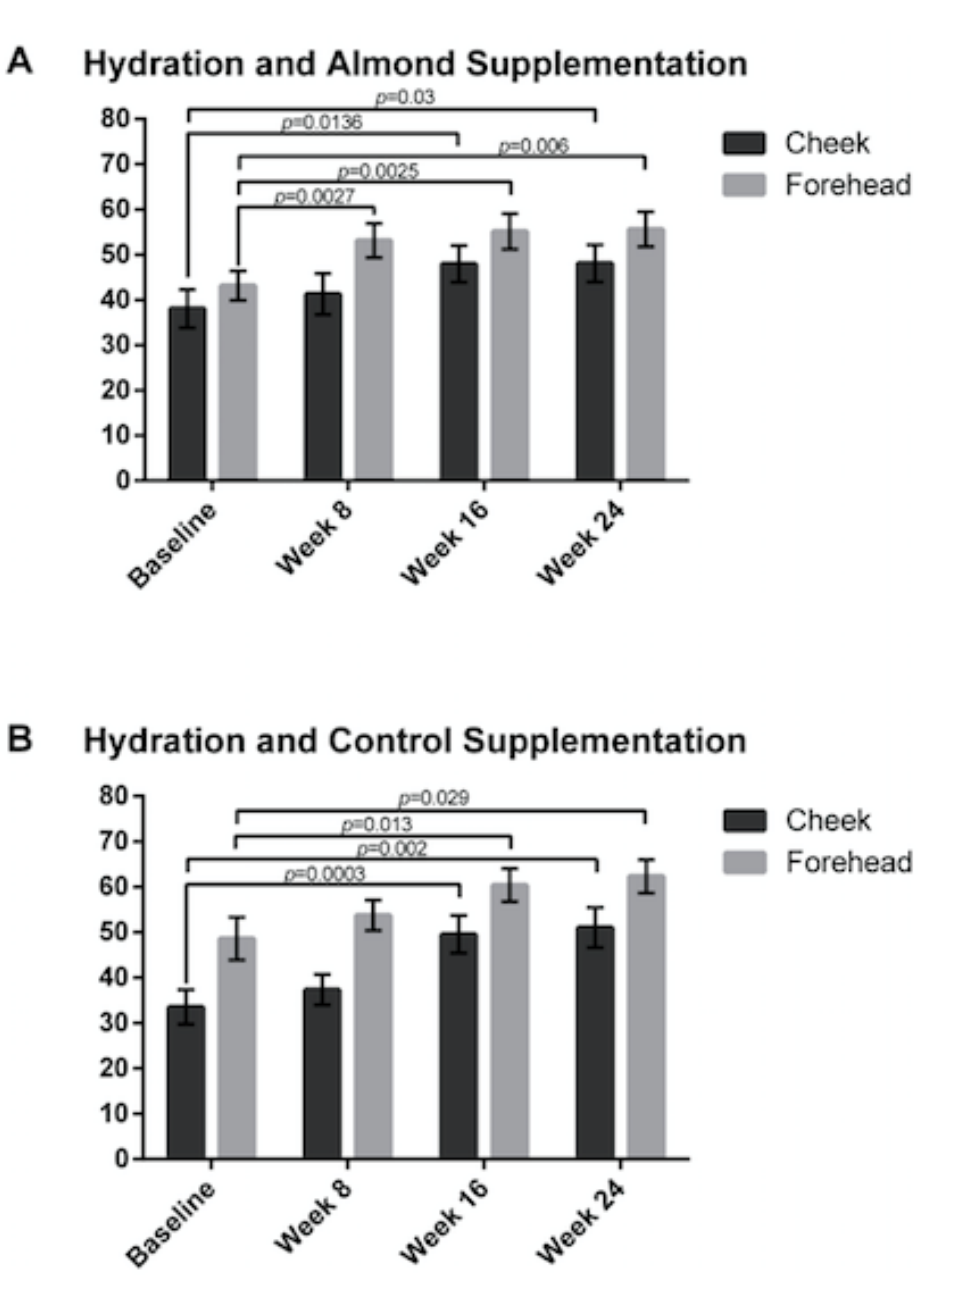
Figure 5. Skin hydration was measured resulting in no significant difference between the ( A ) almond and ( B ) control groups. Significant p values are noted on the figure. Error bars represent SEM.